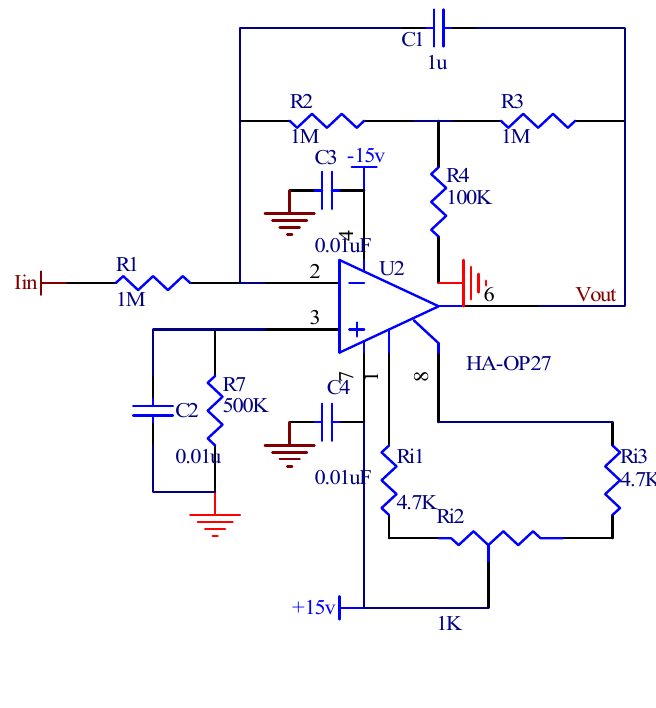
Figure 8. The integral T-style feedback I/V conversion